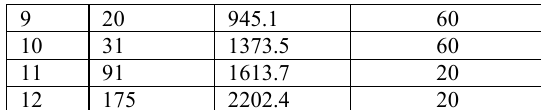
Figure 1. Bayou Perot – Little Lake, New